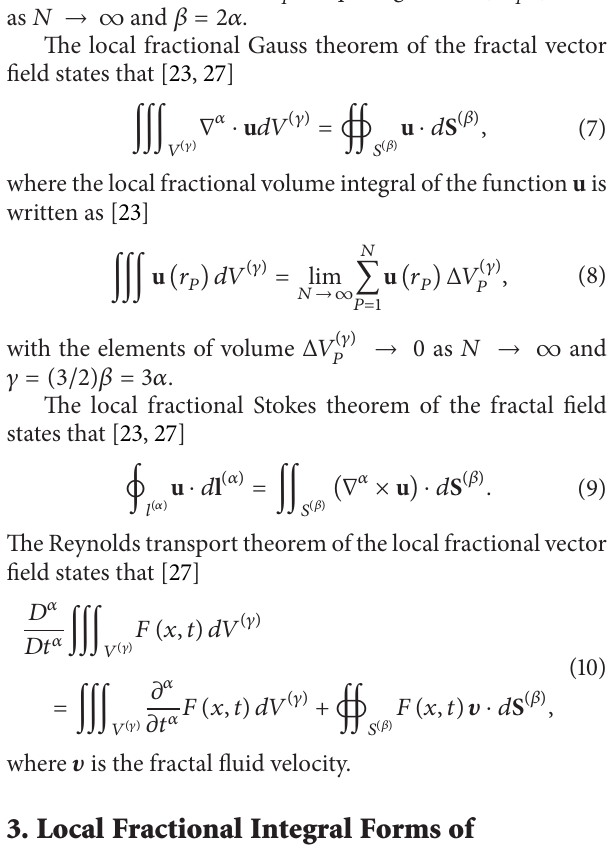
(𝛼) |Δ𝑙 (𝛼) | → 𝑃 requiring that all 𝑃